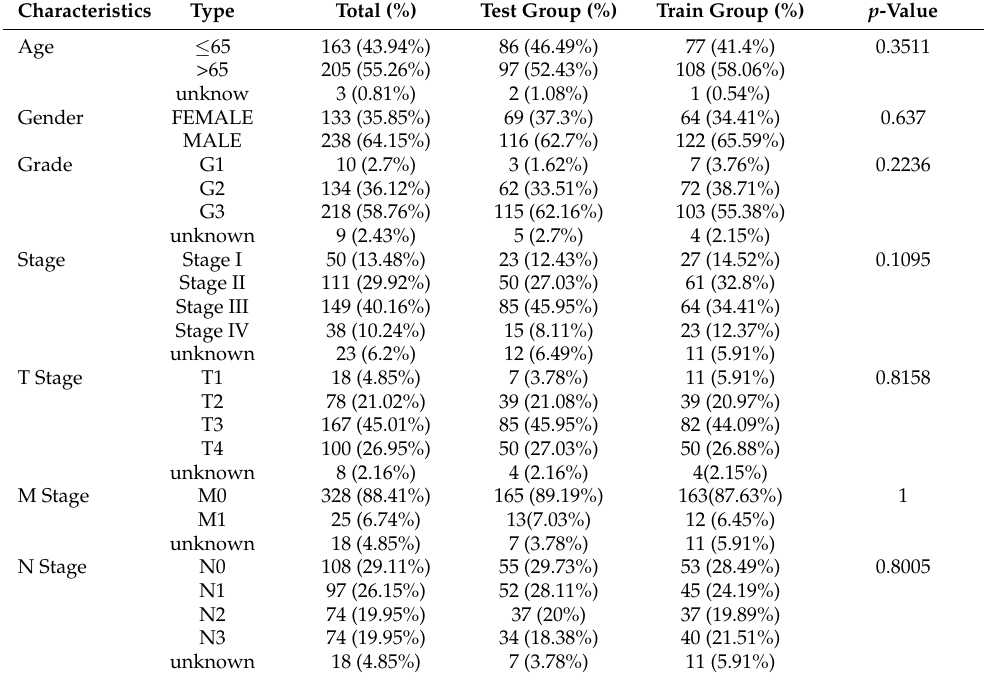
Table 1. The clinical characteristics of STAD patients in the training and test group.